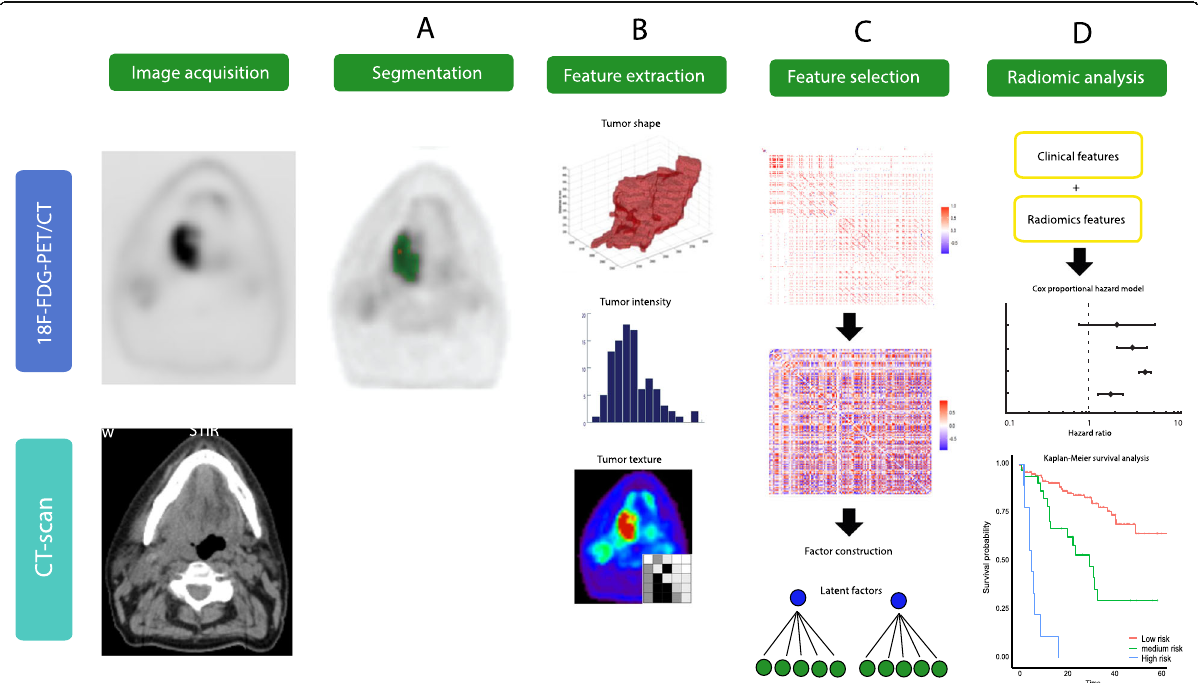
Fig. 1 An overview of the radiomics workflow including a delineation, b extracting of intensity, texture, morphologic, and shape radiomics features. c The removal of redundancy of highly correlated features (Pearson r > 0.95) and the construction of factors. d The construction of prediction models with clinical, first-order PET-features, and/or radiomic factors and the risk-stratification into a high/medium/low risk for developing an event based on the constructed prediction